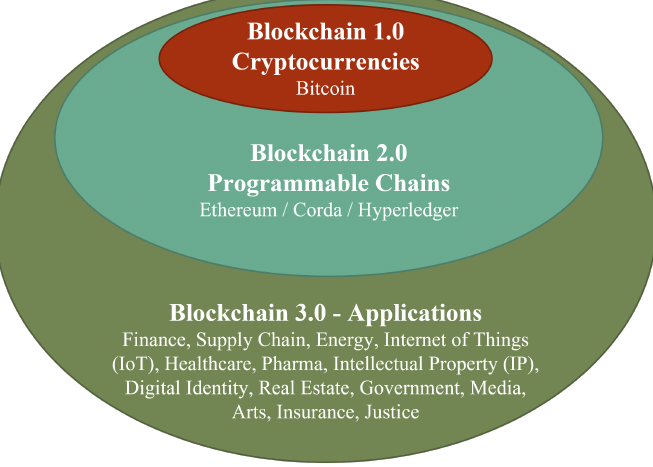
Figure 1. Blockchain ecosystem